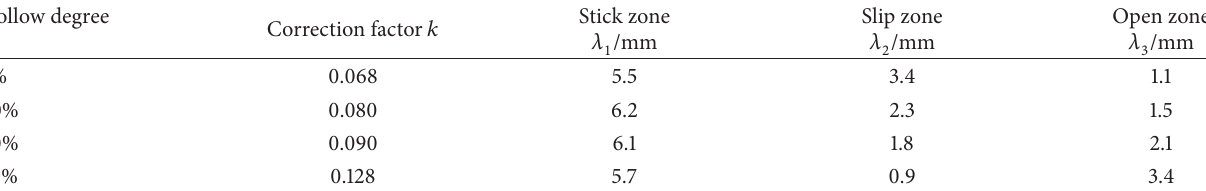
Table 3: Sizes of three zones under different hollow